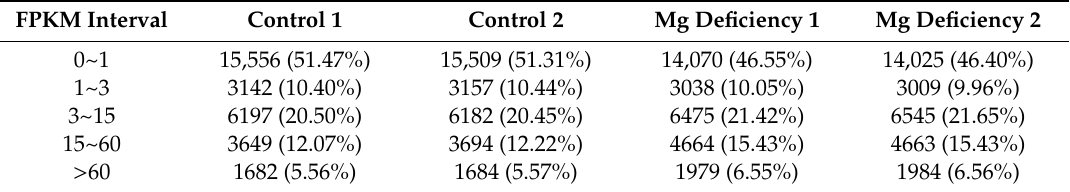
Table 2. FPKM distribution of C. sinensis transcriptome libraries.